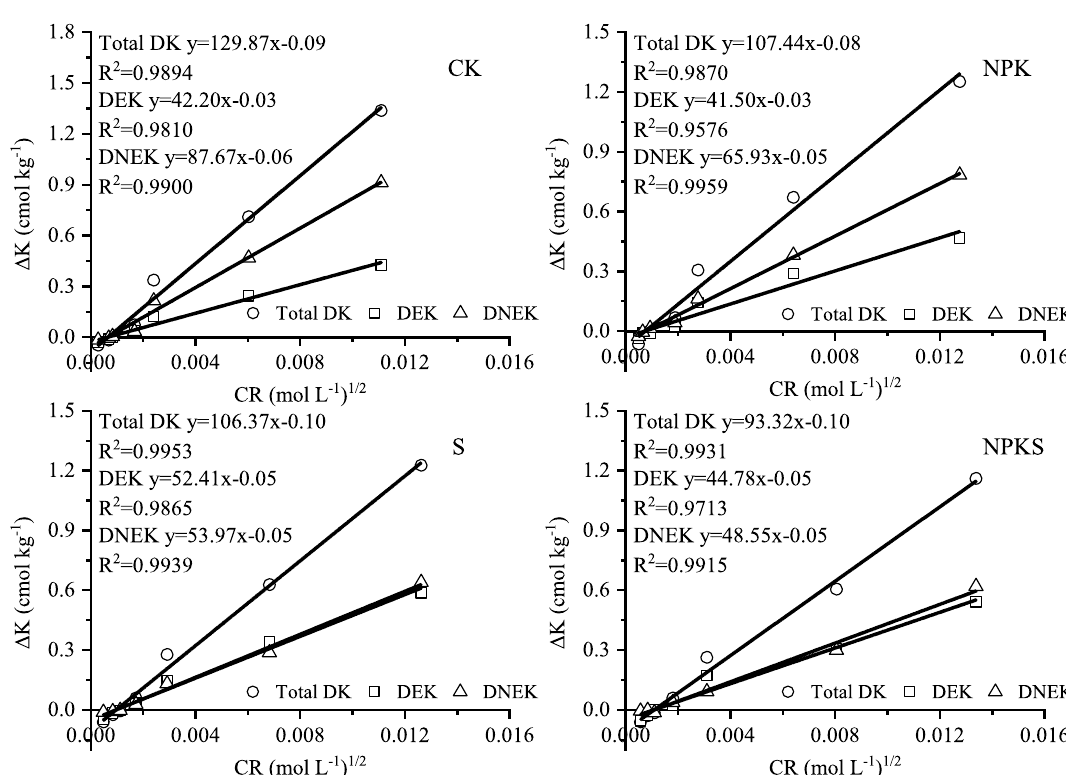
Figure 3. Plots of ΔK versus CR for tested soils with or without straw return. (CK, no fertilization; NPK, mineral fertilizing; S, straw 6000 kg h m −2 ; NPKS, NPK with straw 6000 kg h m −2 ; Total DK or ΔK, amount of total K adsorbed or release from soil during equilibration; CR, potassium concentration ratio, DEK, amount of K adsorbed or release due to exchangeable pool of K during equilibration, DENK, amount of K adsorbed or release due to non-exchangeable pool of K during